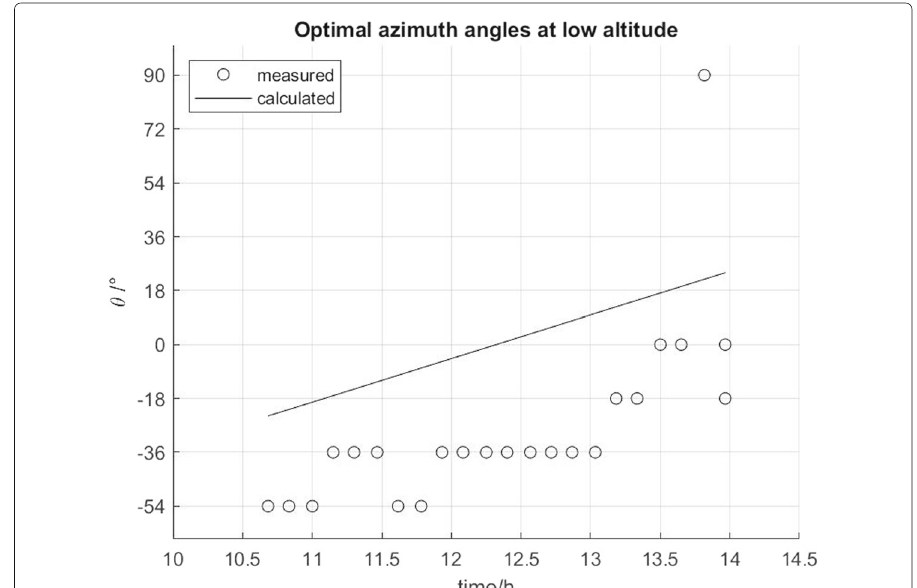
Fig. 11 Optimal azimuth angles at low